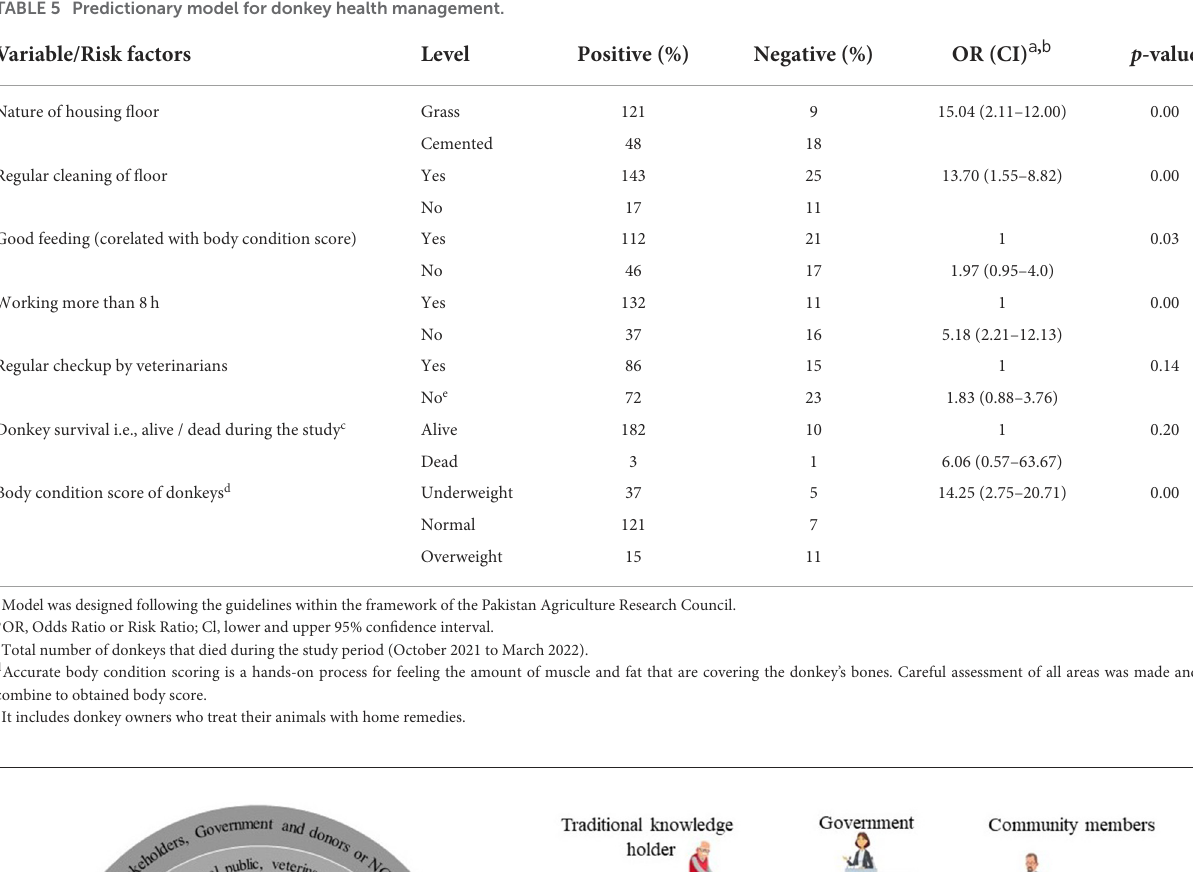
TABLE 5 Predictionary model for donkey health management.